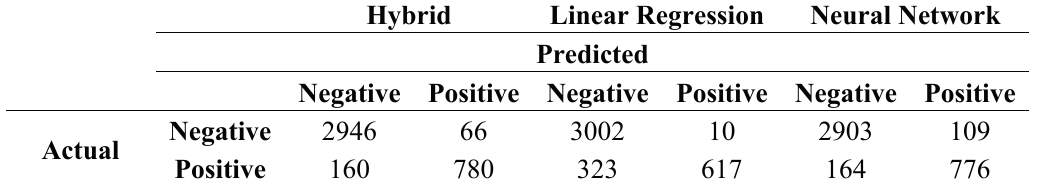
Table 4. Confusion matrix of the hybrid, multivariate linear regression and back-propagation neural network